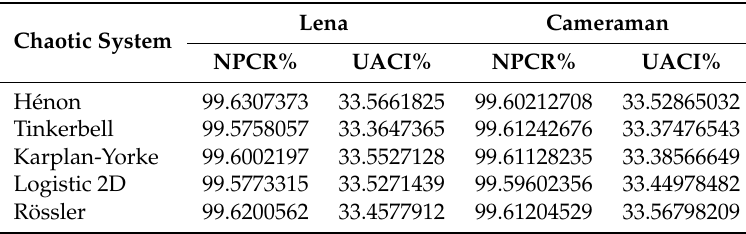
Table 5. NPCR and UACI differential attacks.